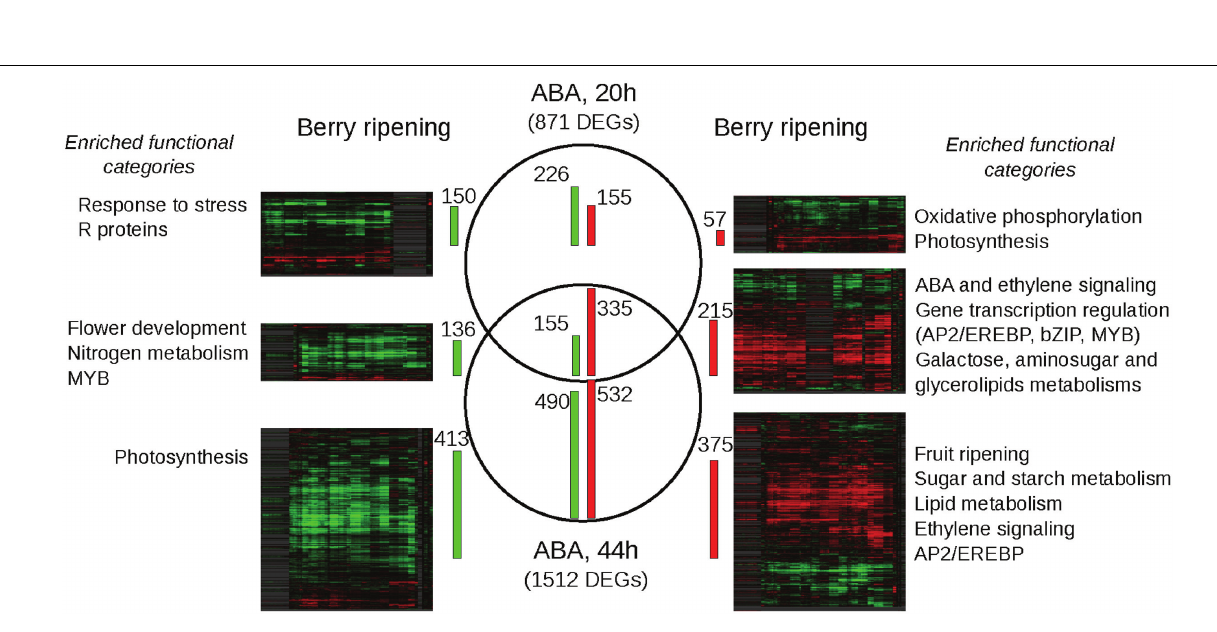
FIGURE 4 | Comparison between the ABA-differentially expressed genes (DEGs) and their modulation during ripening analyzed using the grapevine compendium Vespucci. In the middle, Venn’s diagram of the DEGs between treated vs. control samples at 20 and 44 h, obtained combining statistical significance ( t -test analysis p -value < 0.05) and twofold change threshold. Green bars on the left are proportional to the number of repressed genes, while red bars on the right to the number of induced genes. On left and right sides, heatmaps of the down- and up-ABA modulated genes obtained in Vespucci, selecting 7 experiments on berry ripening performed in six Vitis vinifera cv.: Cabernet Sauvignon (GSE11406), Sauvignon Blanc (GSE34634), Corvina (GSE36128), Pinot Noir (GSE49569 and GSE31674), Muscat Hamburg (GSE41206) and Norton (GSE24561). Genes are clustered according to their expression profiles. The number of the transcripts coherently modulated in ABA treatment and berry ripening is indicated beside the heatmaps by green/red bars. Outer left and right columns, enriched functional categories of each subset of genes coherently modulated by ABA and during ripening are reported. For the complete output of the GO and Vitisnet enrichment analyses, refer to Supplementary Table